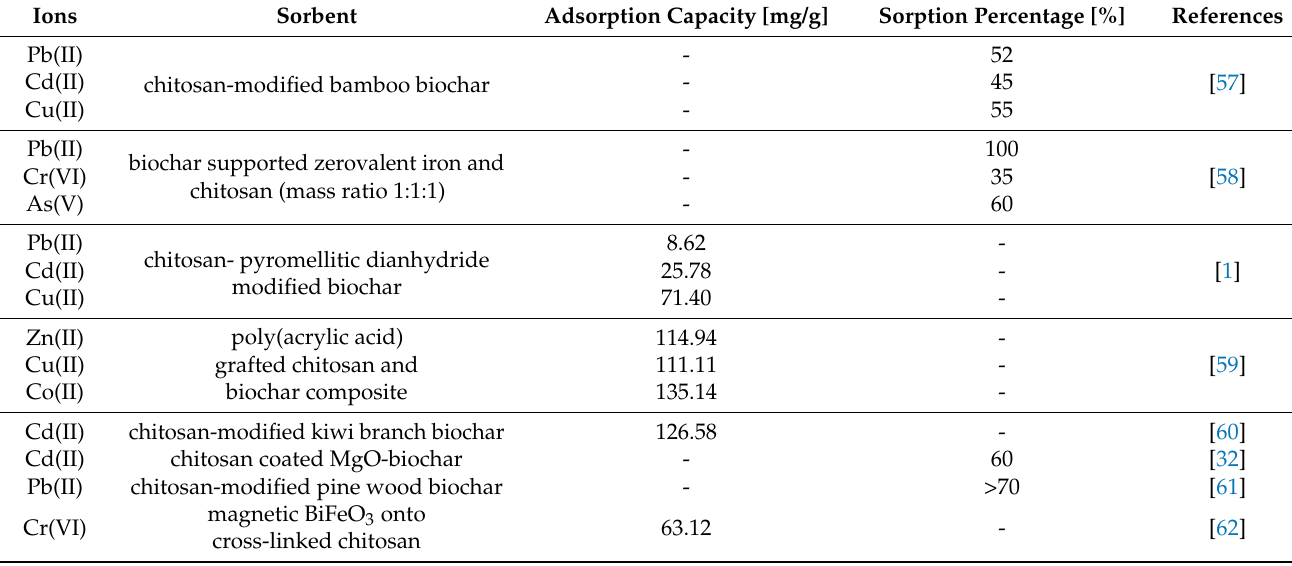
Table 6. Parallel results of the adsorption capacities/sorption percentages of metal ions sorbed on different types of chitosan-modified